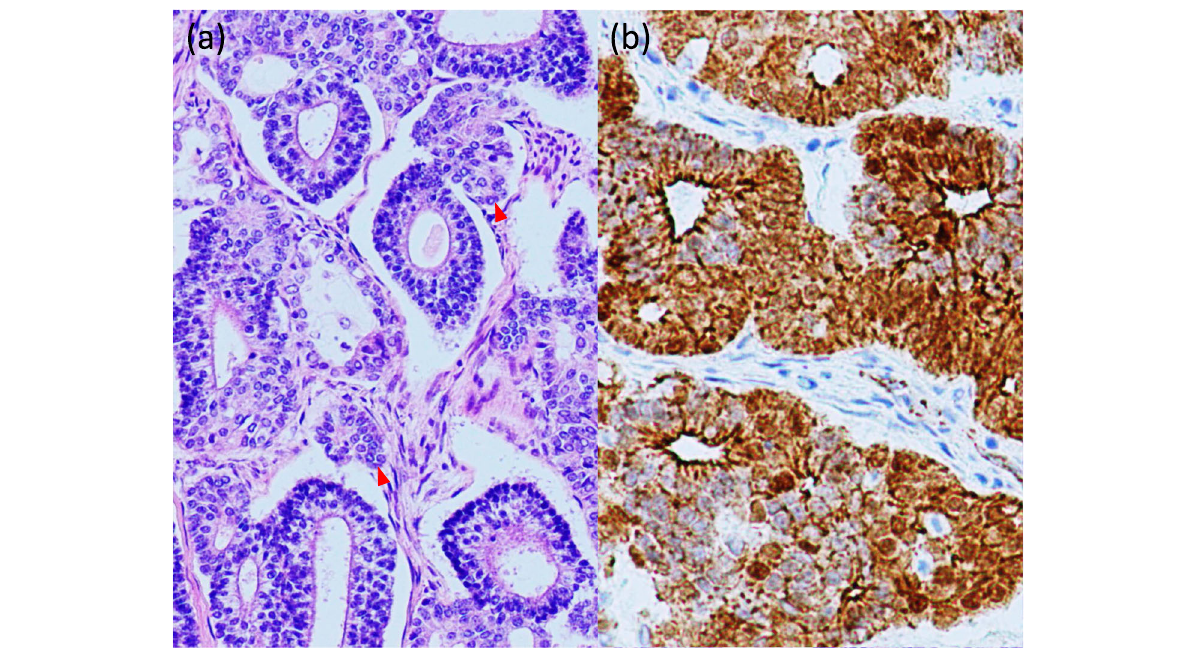
Fig. 2 Microscopic examination of the surgical resection specimen. a Hematoxylin and eosin-stained section showed glands comprising single or double layers of nonciliated cells and some morule formations (red arrowhead). b Immunohistochemical examination showed a positive result for β